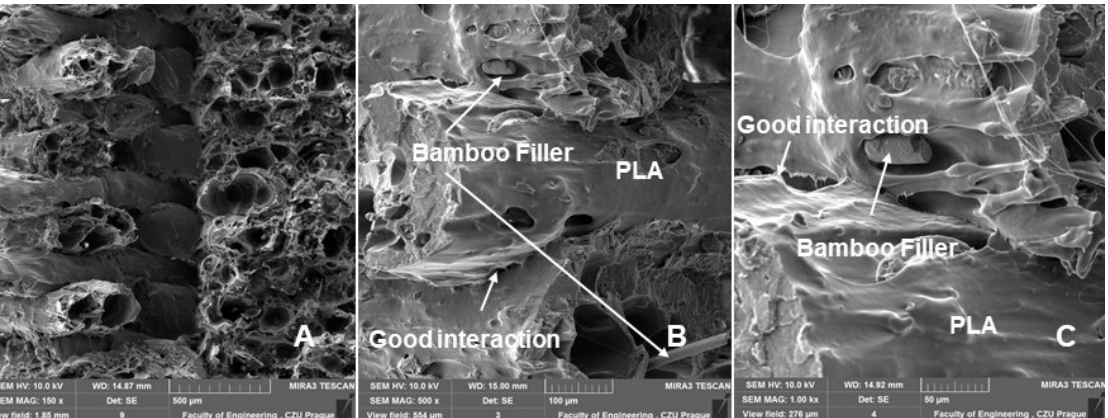
Figure 11. SEM images—fractographic analysis—nozzle 0.6 mm, infill density 60%, static tensile test—connection of individual layers, arrangements, and their porosities: ( A ): MAG 150×; ( B ): MAG 500×; ( C ): MAG 1.00 kx.